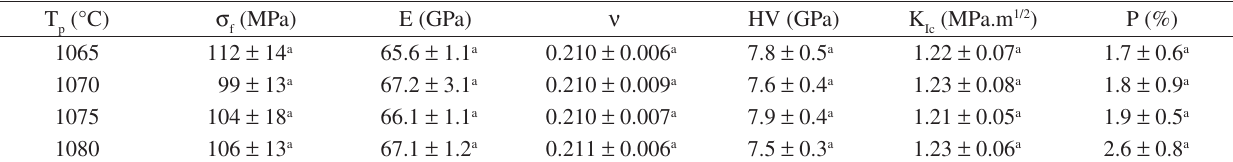
Table 1. Mean ± standard deviations for biaxial flexural strength ( σ ) in artificial saliva at 37 °C, Young’s modulus (E), Poisson’s coefficient ( ν ), Vickers hard- f ness (HV), fracture toughness (K ) and volume fraction of porosity (P) for the different pressing temperatures (T Ic followed by the same superscript are statistically similar (p > 0.05).